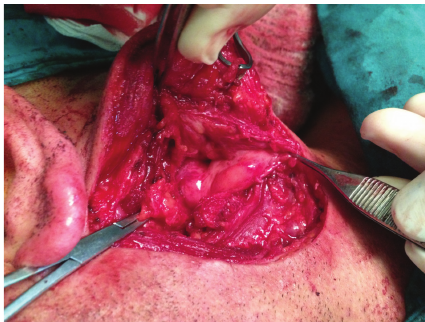
Figure 3: The tumor had a large vascular space lined by flattened epithelium and lymphoid aggregates in the surrounding fibroblastic stroma (H&E, × 200).